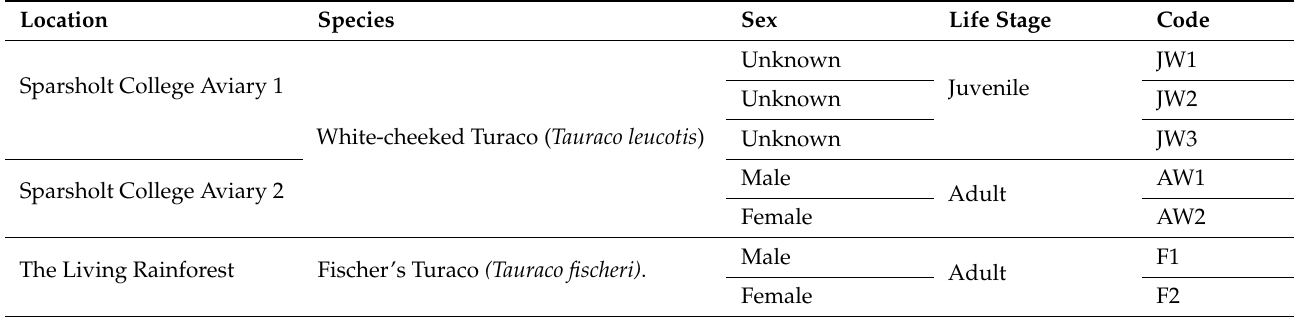
Table 1. Study subjects and